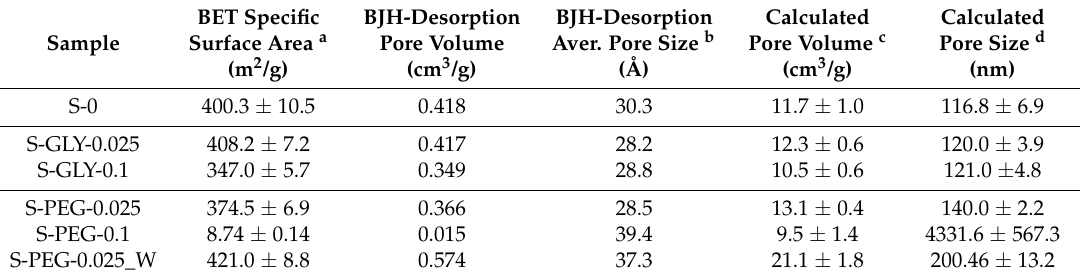
Table 3. Specific surface area, pore volume and size of the aerogel-like materials with and without additives.